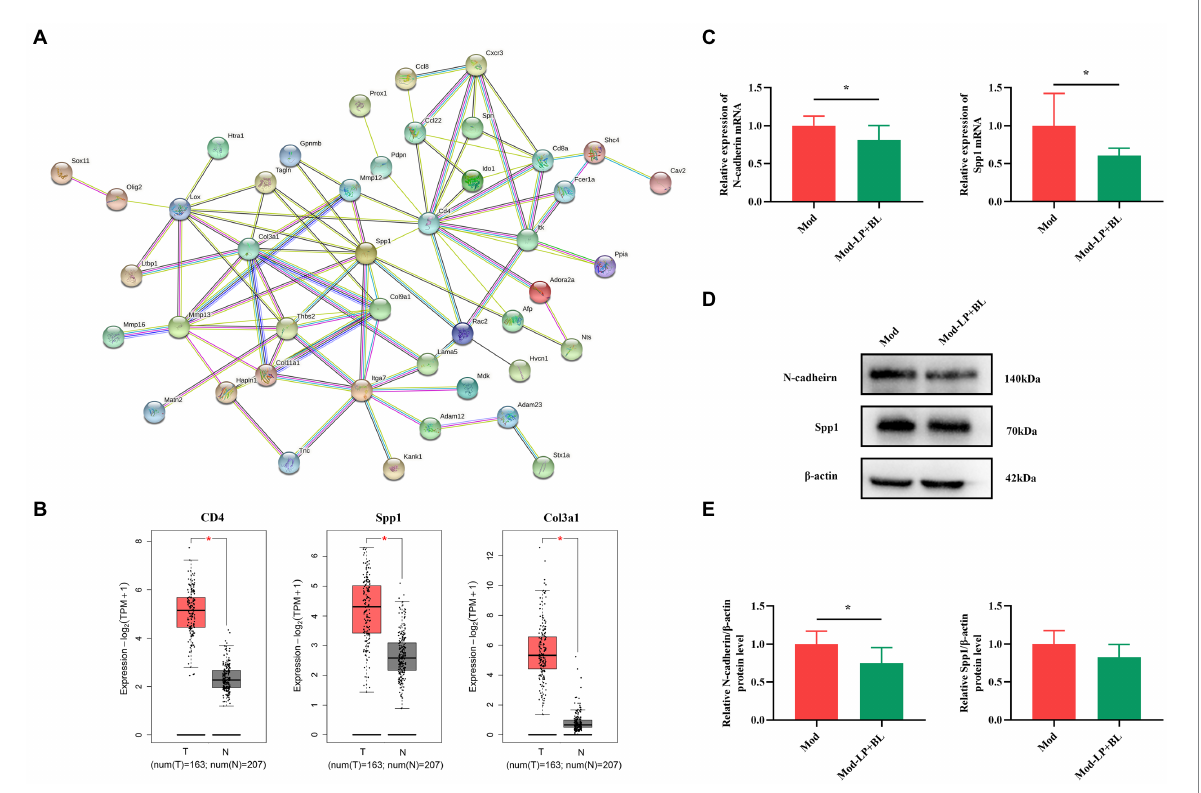
FIGURE 5 Effects of B. lactis and L. plantarum on the migration and invasion-related genes in glioma mice. (A) PPI network. (B) Differential expression of CD4 , Spp1 and Col3a1 in normal and glioma tissues from TCGA and GTEx datasets. (C) mRNA expression of N-cadherin and Spp1 in glioma tissues in Mod and Mod-LP + BL groups. n = 6, two-tailed Student’s T-test. (D) Representative immunoblots and (E) quantitative analysis of N-cadherin and Spp1 in glioma tissues. n = 6, two-tailed Student’s T-test. Mod, Model. LP, Lactobacillus plantarum ; BL, Bifidobacterium lactis . T, tumor. N, normal. * p < 0.05, ** p < 0.01, *** p <